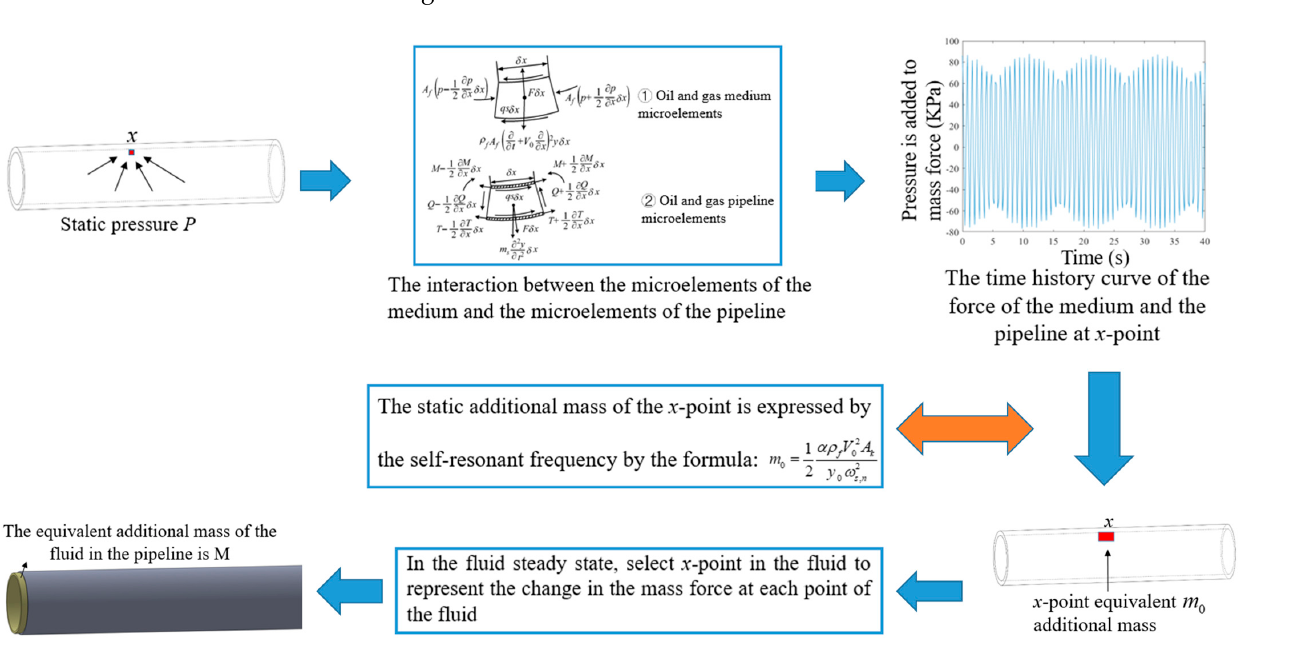
Figure 2. Additional-mass-dynamics analysis of oil and gas transmission